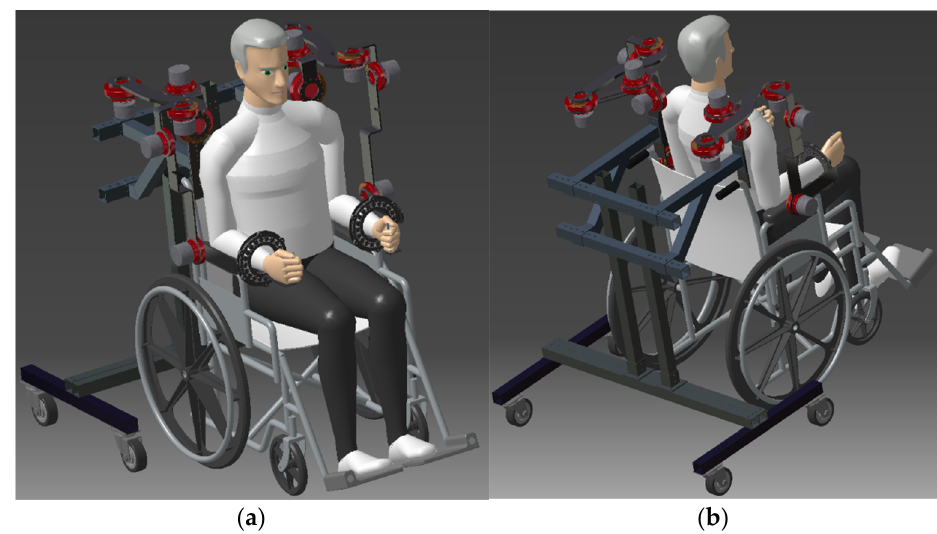
Figure 1. Three-dimensional model of CardioVR-ReTone robotic exoskeleton: ( a ) front view and ( b ) rear view.